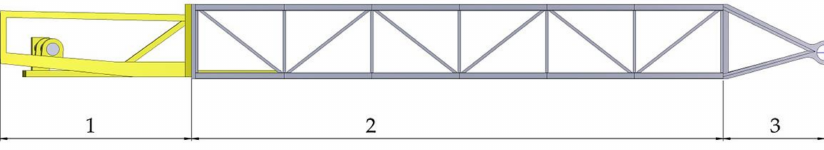
Figure 10. Sections of the bucket wheel boom model.